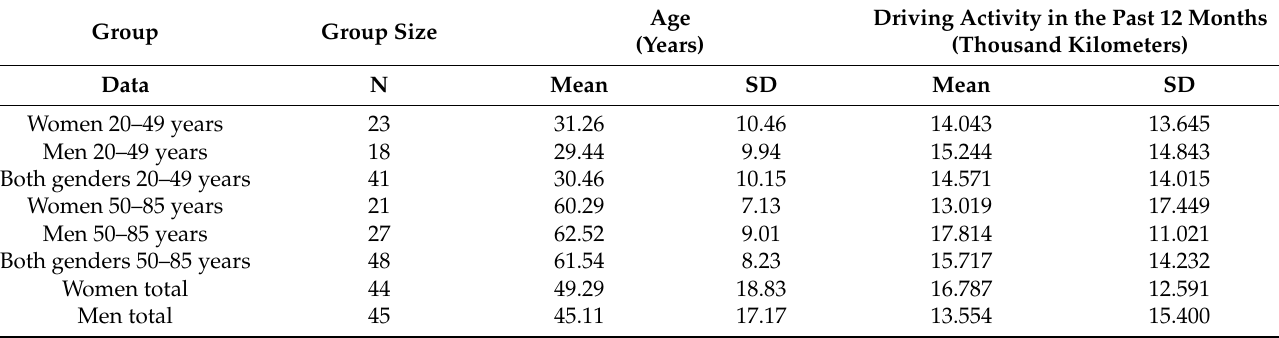
Table 1. Age and driving activity of the